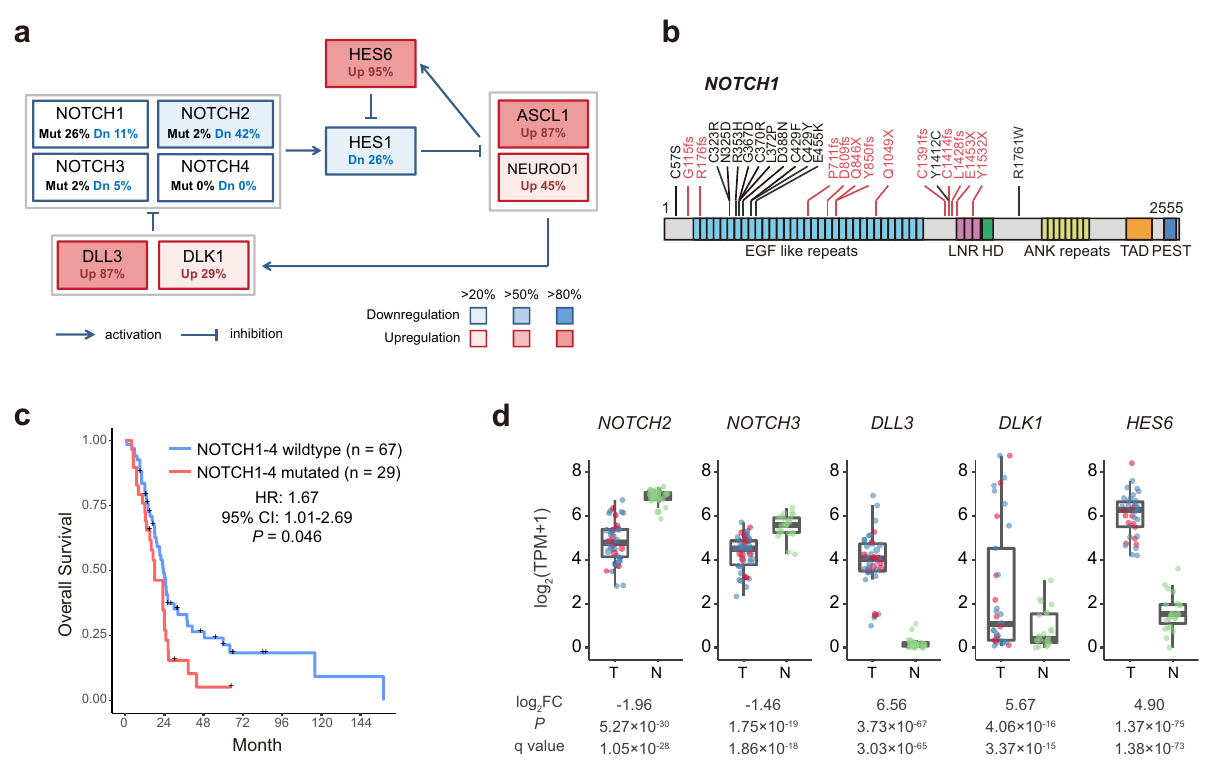
Fig. 5 Notch pathway was inactivated in PSCCE. a A schematic plot of Notch pathway dysregulation in PSCCEs. Up: upregulated, de fi ned by having expression higher than three times of 95% quantile of 23 normal esophageal samples; Dn: downregulated, de fi ned by having expression lower than one- third of 5% quantile of 23 normal esophageal samples; Mut: mutated. The proportions of tumors showing dysregulation are denoted as percentages, which are also indicated by color intensities according to the color legend. b Mutations of NOTCH1 were enriched in extracellular EGF-like repeats. Truncating mutations are plotted in red. c Kaplan – Meier plots of overall survival of PSCCE patients. Patients with mutated NOTCH1-4 had signi fi cantly poorer prognoses. d The dysregulation of Notch pathway components was observed regardless of Notch receptor status. The red dots represent tumors harboring mutations in Notch receptors ( NOTCH1-4 ) and blue dots represent tumors with wild-type Notch receptors. Log 2 (foldchange), P and q values determined by DESeq2 are shown below. T tumors. N normal samples. The upper bound, centerline, and lower bound of boxplot represent the 75 percentile, the median, and the 25 percentile of data; the upper and lower whiskers extend to the largest and smallest value within 1.5 times of IQR from corresponding bound. Data beyond the whiskers are plotted as outlier dots. Source data are provided as a Source Data fi